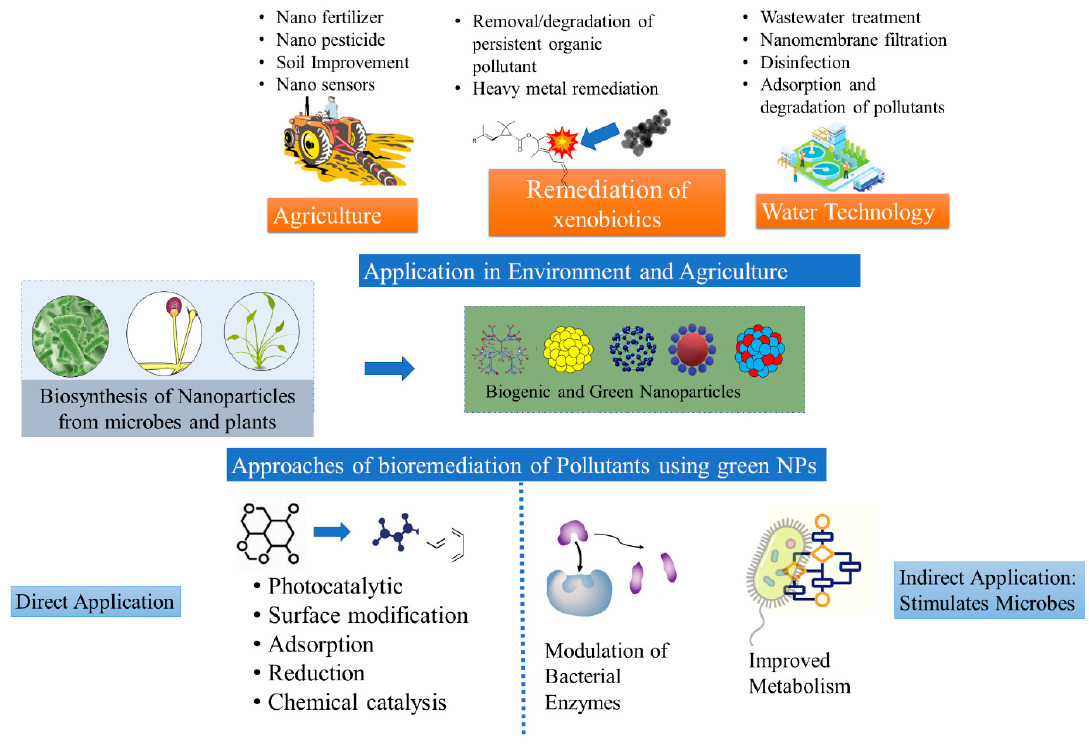
Figure 3. Biogenic Nanoparticles and their application in environment and agriculture ( top ) the bioremediation approach for the removal of toxic pollutants from the environment ( bottom ). Reprinted/adapted with permission from Ref. [47].